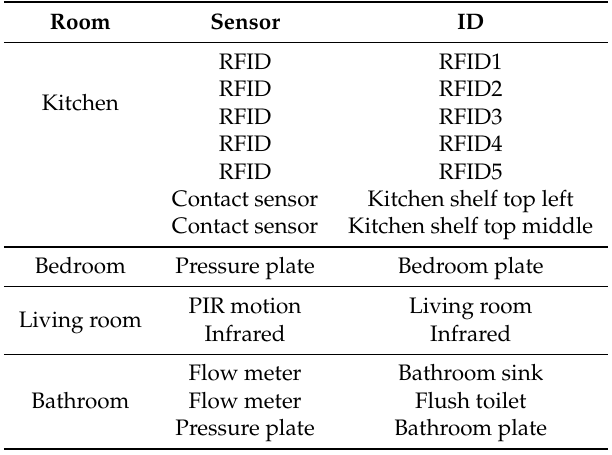
Figure 13. Screenshot of the home architecture for our scenario and the location of sensors. Table 5. List of sensors in our example. Figure 13 shows position of